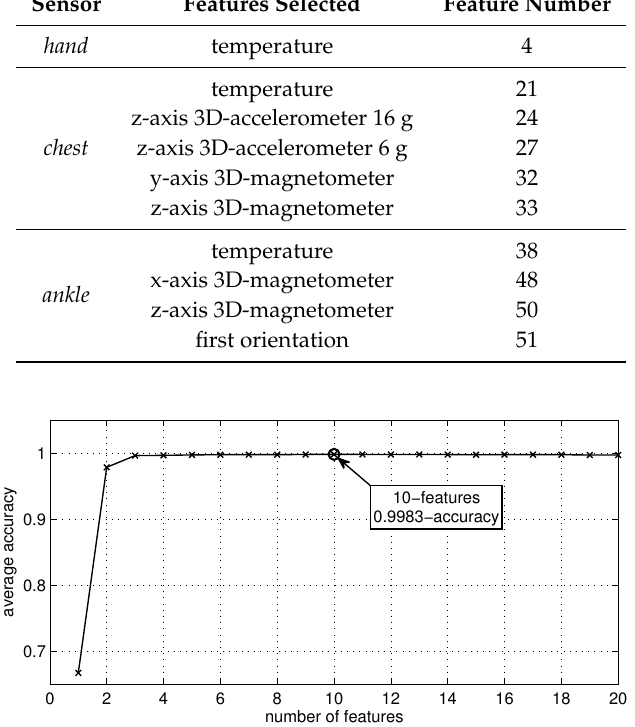
Figure 4. Average accuracy of models with respect to the number of features selected using